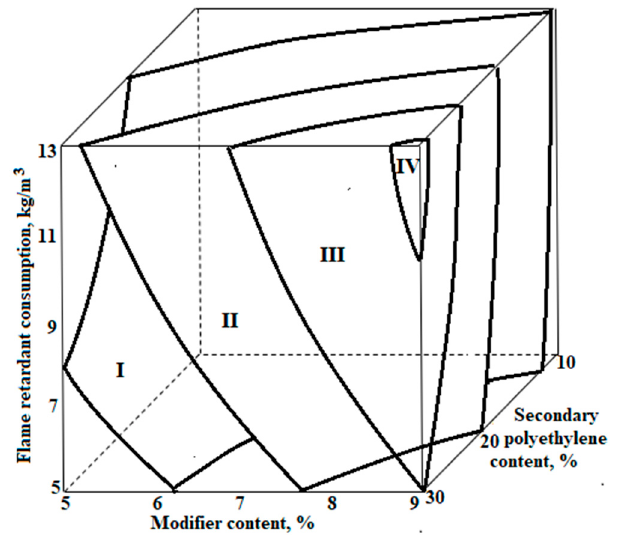
Figure 5. Dependence of compressive strength at 10% deformation of polyethylene foam samples on variable factors: I—200 kPa; II—180 kPa; III—160 kPa; IV—140 kPa.